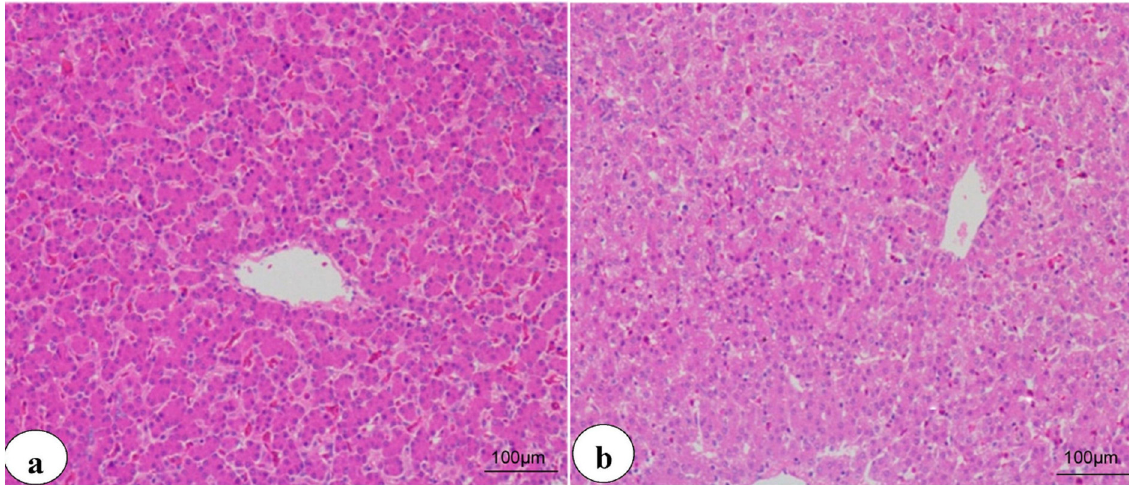
Figure 2. Photomicrographs of liver sections from chickens of the control group showed normal histopathological structures at the end of the 3rd week ( a ) and 6th week ( b ).